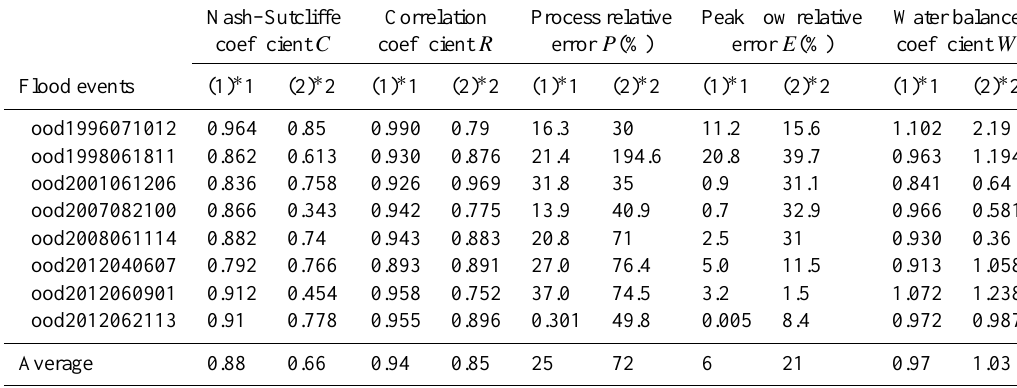
Figure 8. Simulated flood events of UMWC: (a) flood1981040712, (b) flood1981041310, (c) flood1983022720 and (d) flood1987052012. Table 6. The evaluation index of the simulated flood events in Tiantoushui catchment.